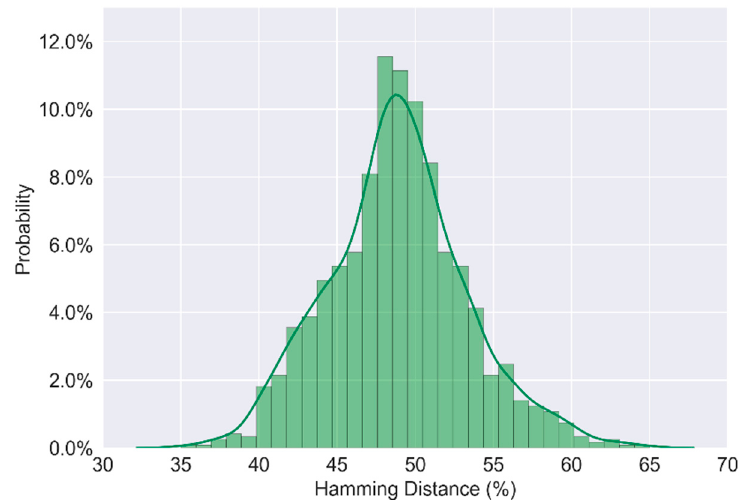
Figure 11. Uniqueness of responses.